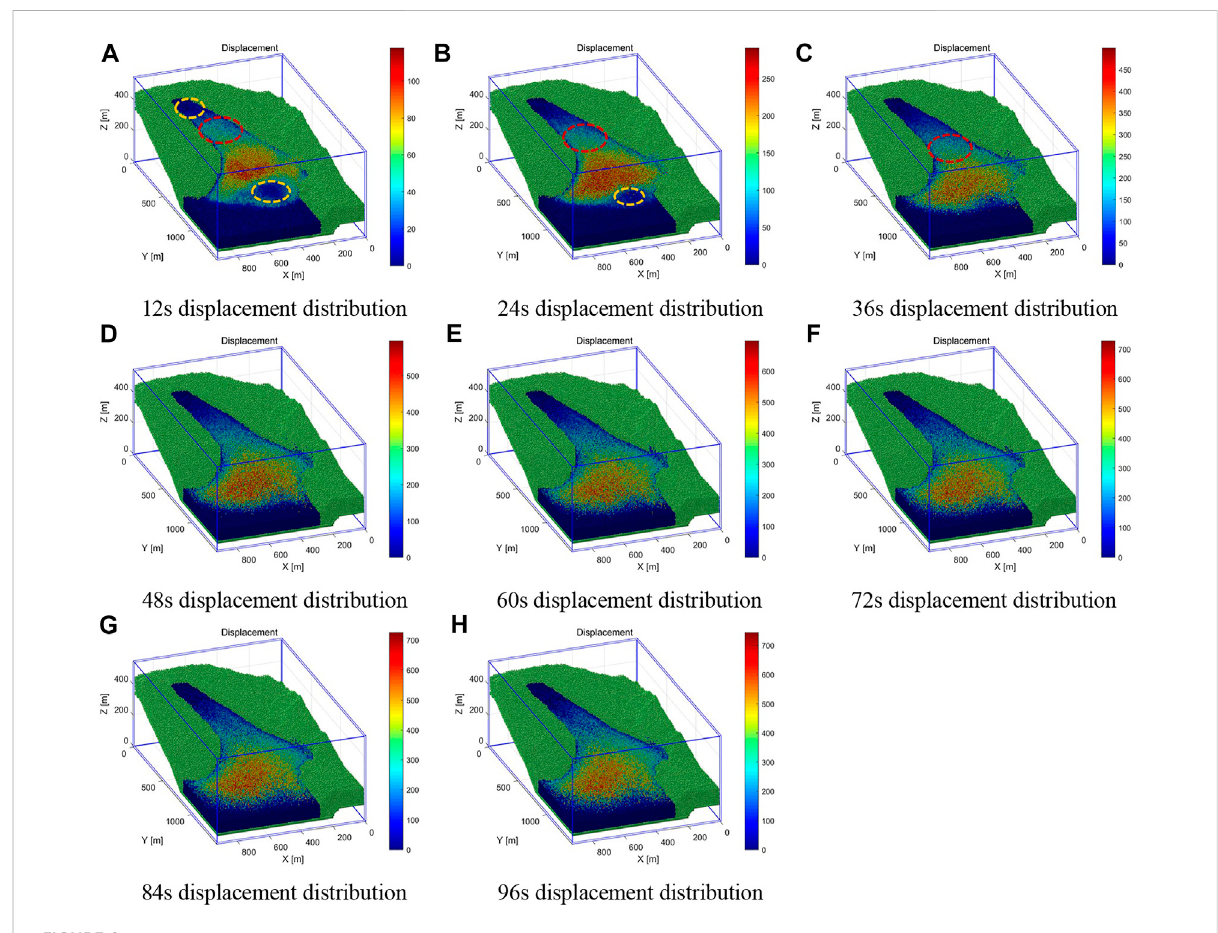
FIGURE 9 Distribution of displacement with time during landslide process(m). (A) 126 s displacement distribution, (B) 246 sdisplacementdistribution, (C) 366 s displacement distribution, (D) 486 s displacement distribution, (E) 606 s displacement distribution, (F) 726 s displacement distribution, (G ) 846 s displacement distribution, (H) 966 s displacement